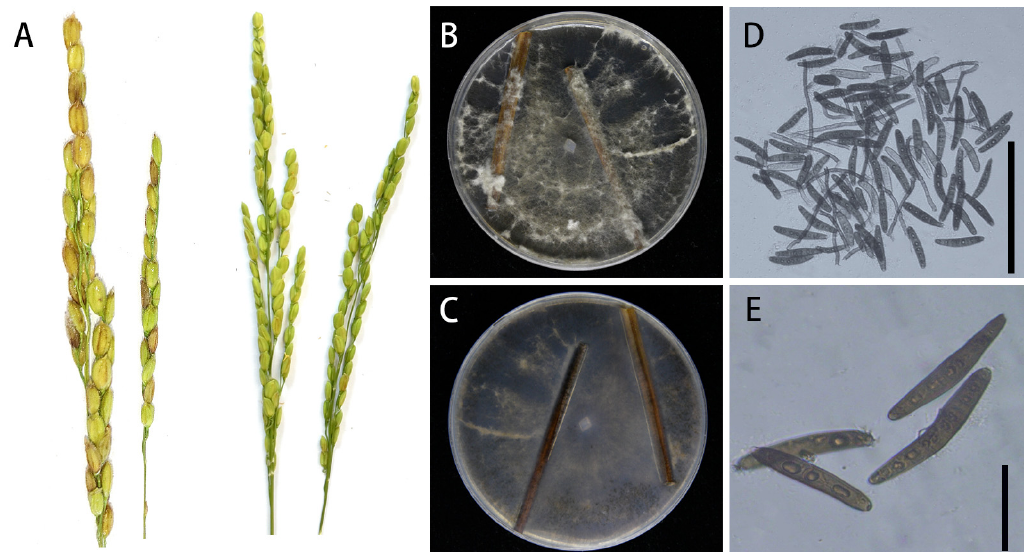
Figure 1. Morphological characteristics of E. rostratum LWI. ( A ) Disease symptoms and experimental control group of the E. rostratum LWI strain on rice. ( B , C ) Growth of E. rostratum LWI on TWA-W agar (front and reverse). ( D , E ) Conidia produced by E. rostratum LWI on TWA-W agar. The ( D ) picture bar = 200 µ m, and the ( E ) picture bar = 50 µ